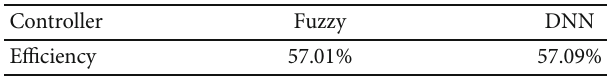
(b) Fuel cell e ffi ciency comparison: fuzzy and